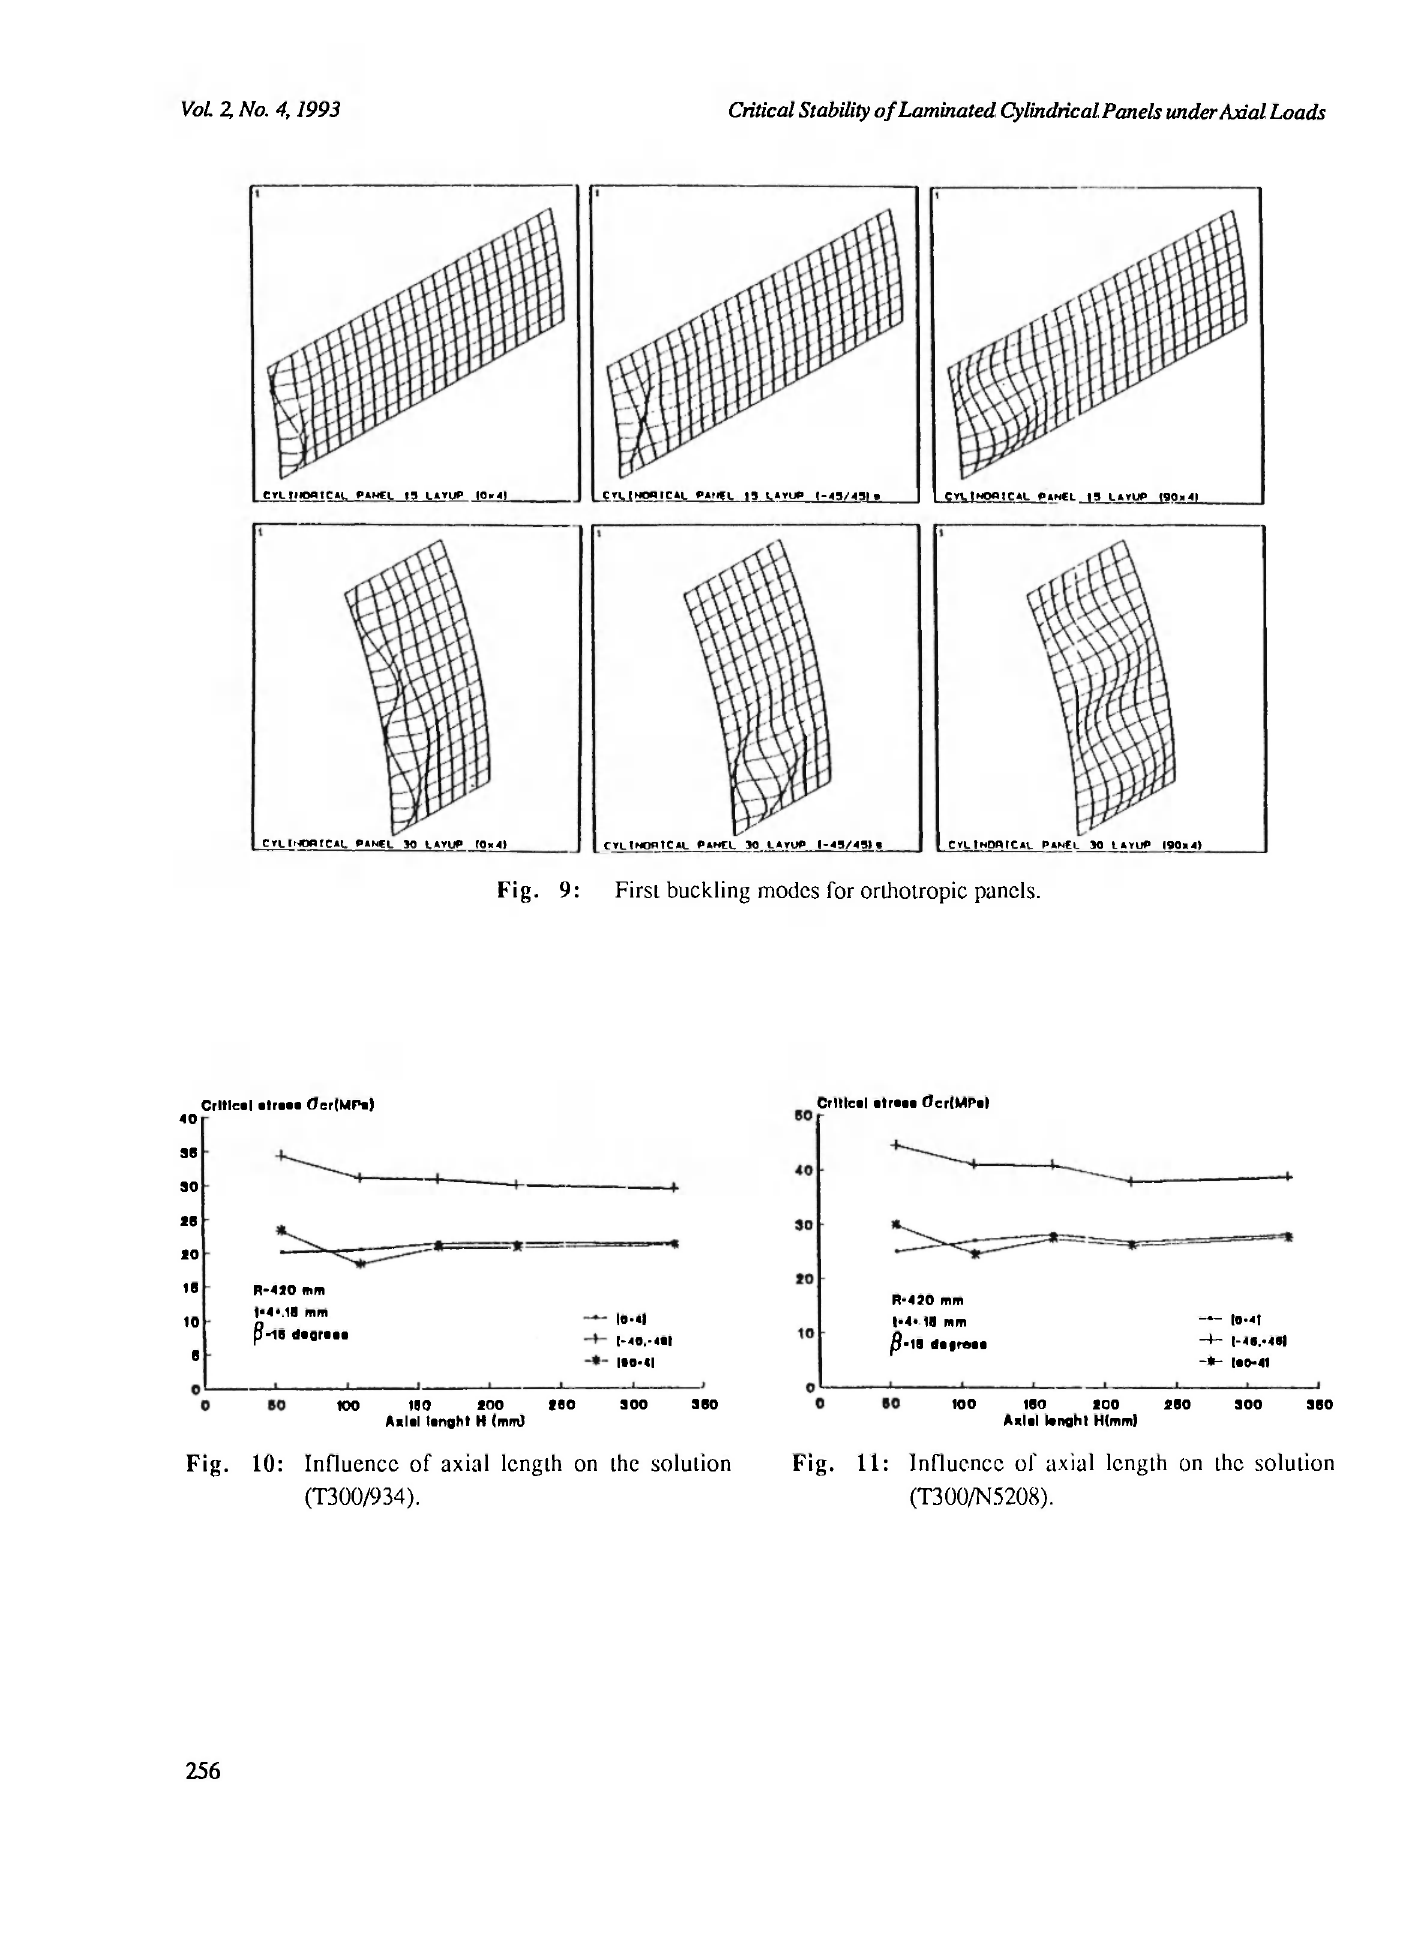
11: Influence of axial length on the solution